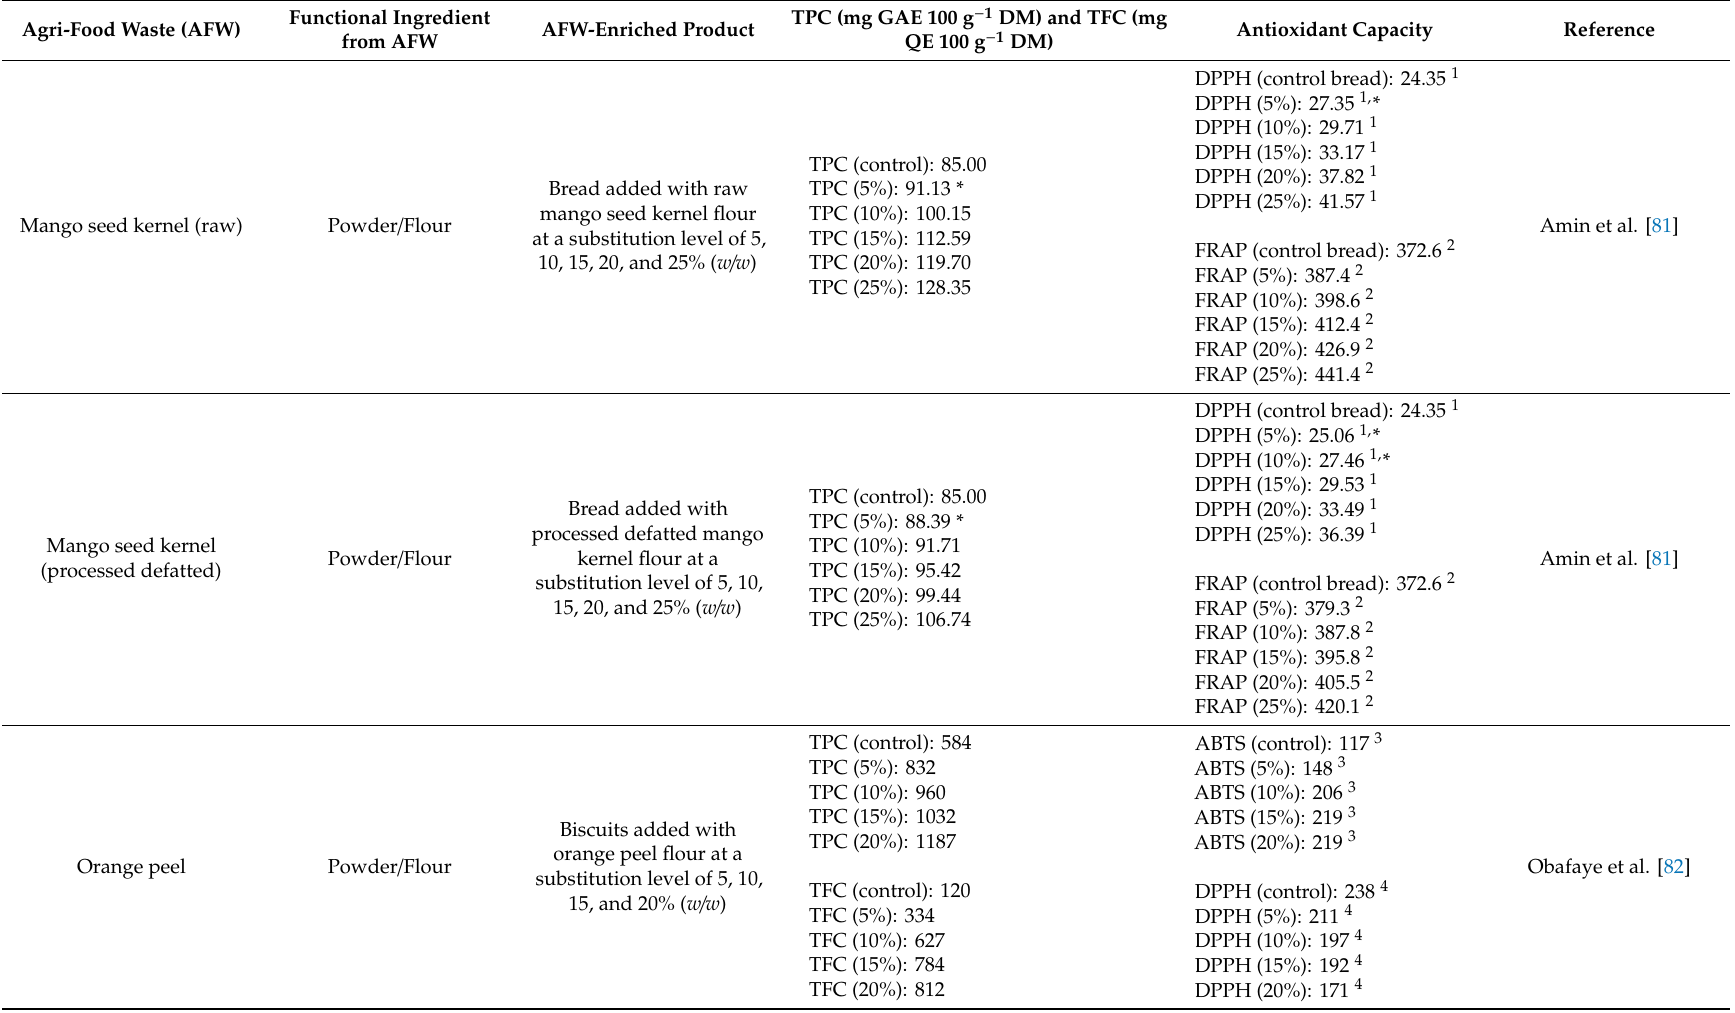
Table 1. TPC and antioxidant capacity of cereal-based products formulated by the addition of waste from fruit and